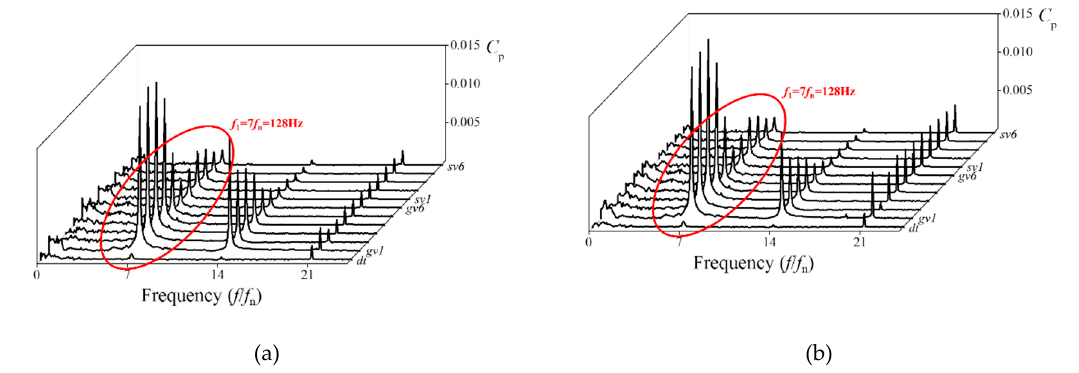
Figure 11. FFT results of pressure fluctuations at condition ( a ) III and ( b ) IV.